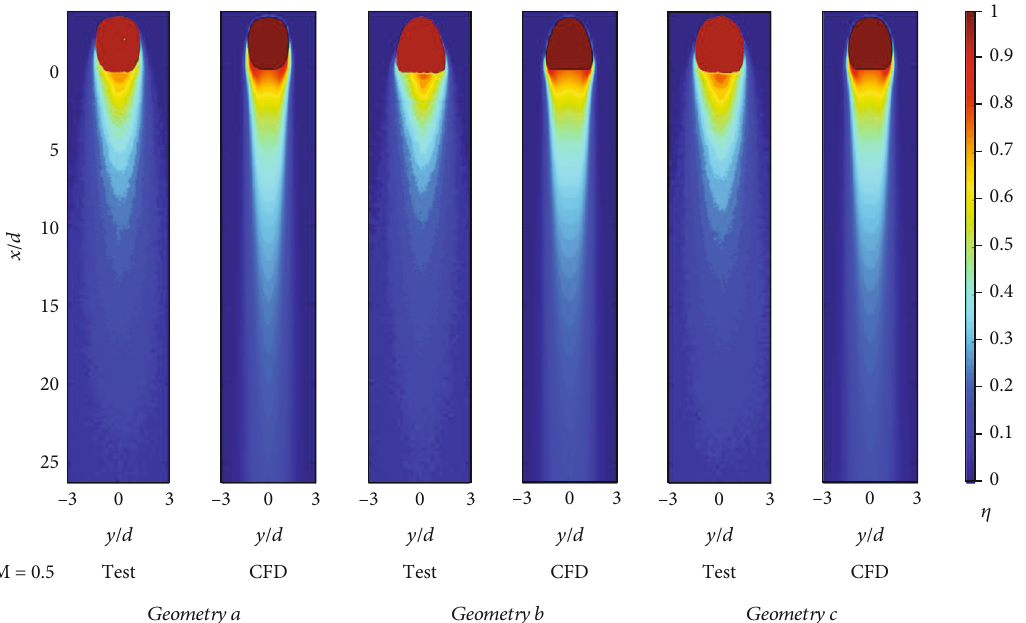
Figure 10: Test and CFD comparison of e ff ectiveness contours for the blowing ratio of 0.5.